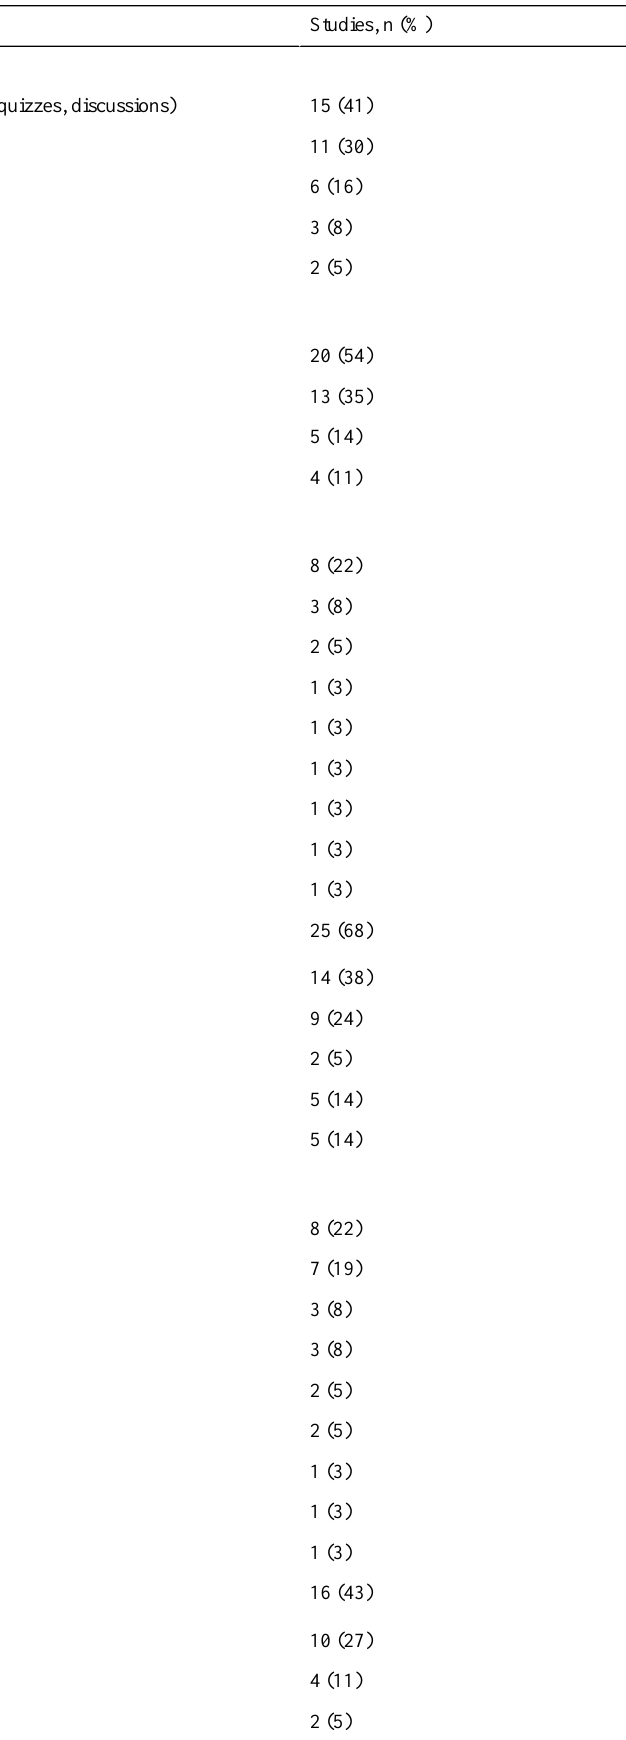
Table 3. Intervention type, online support, and features description